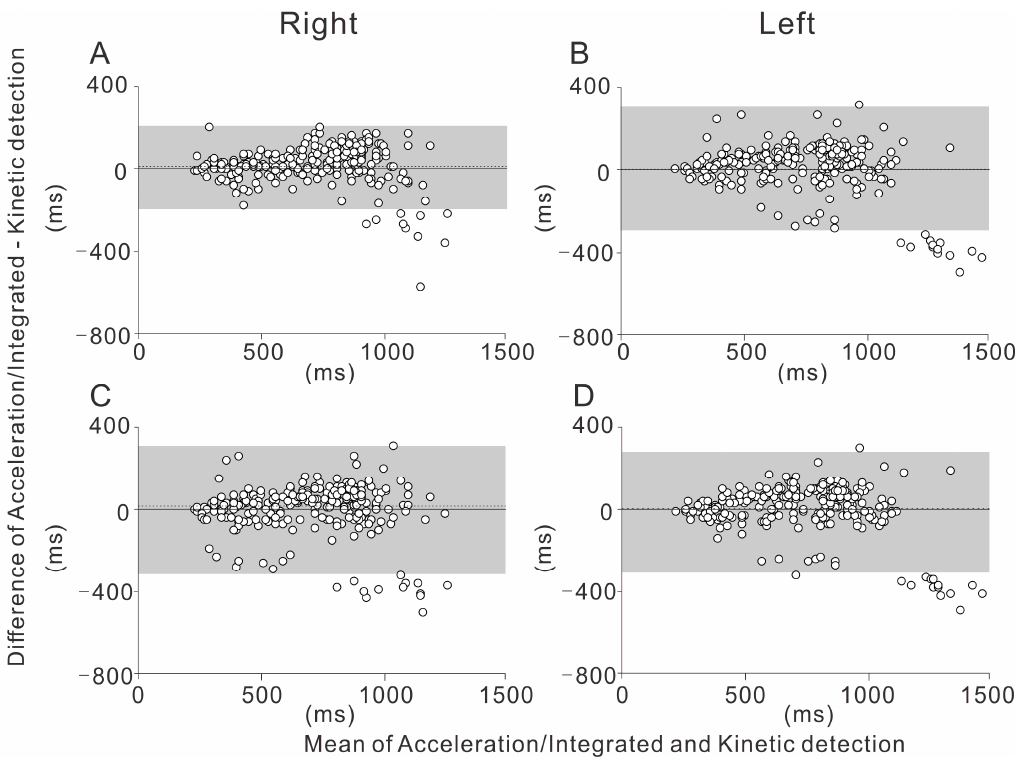
Figure 2. The Bland-Altman plot depicts the differences between the different detection methods in the straight, with 95% limits of agreement. The mean difference is shown by the dotted line. The 95% confidence intervals of the limits of agreement are also depicted (gray-shaded area). ( A ) Acceleration detection on the right side. ( B ) Acceleration detection on the left side. ( C ) Integrated detection on the right side. ( D ) Integrated detection on the left side.